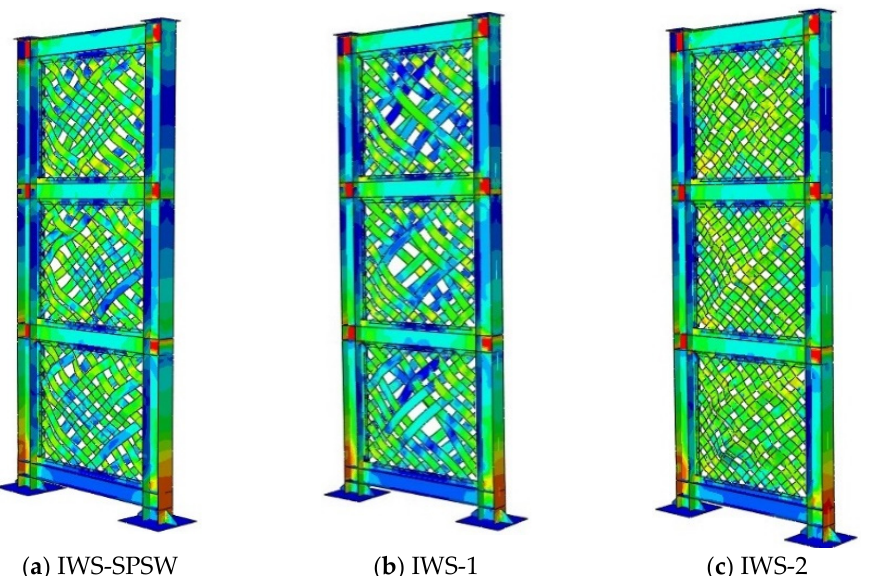
Buildings 2022 , 12 , x FOR PEER REVIEW 19 of 24 Figure 16. Parametric FE models: Effect of the infill-strip bolt connections. Figure 16. Parametric FE models: Effect of the infill-strip bolt connections.